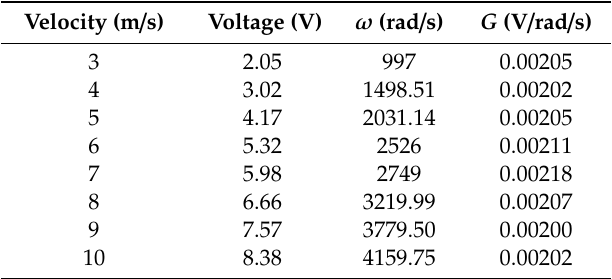
Table 14. Electro-mechanical coe ffi cient for di ff erent air velocities. Velocity (m /